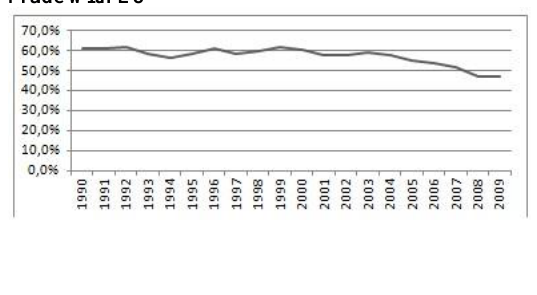
Figure 3. Share of Turkish Total Manufacturing Trade with